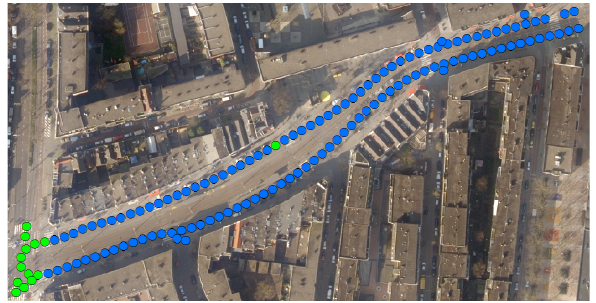
Figure 10. Test area 3; green: recording locations with correspondences to the aerial images; blue: recording locations without